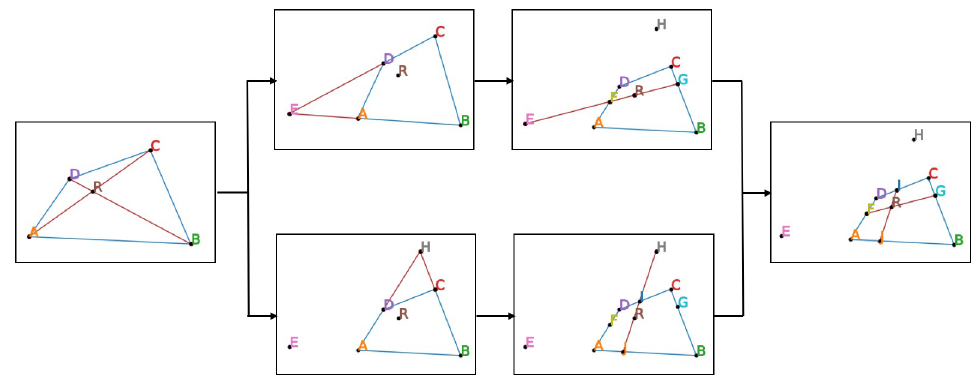
Fig 2. Division of the polygon ABCD into equal size